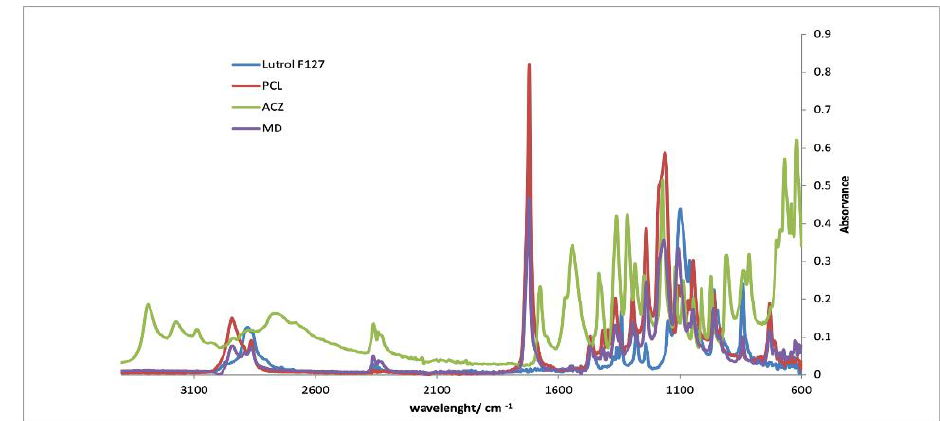
Figure 5. FTIR spectra of MD implants compared with PCL, Lutrol F127 and acetazolamide.